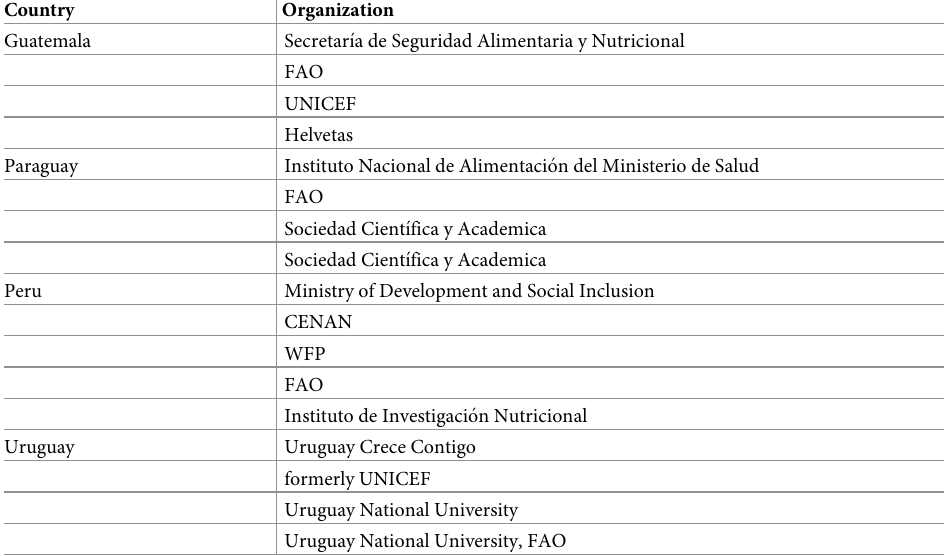
Table 2. Affiliation of key informants in selected countries.